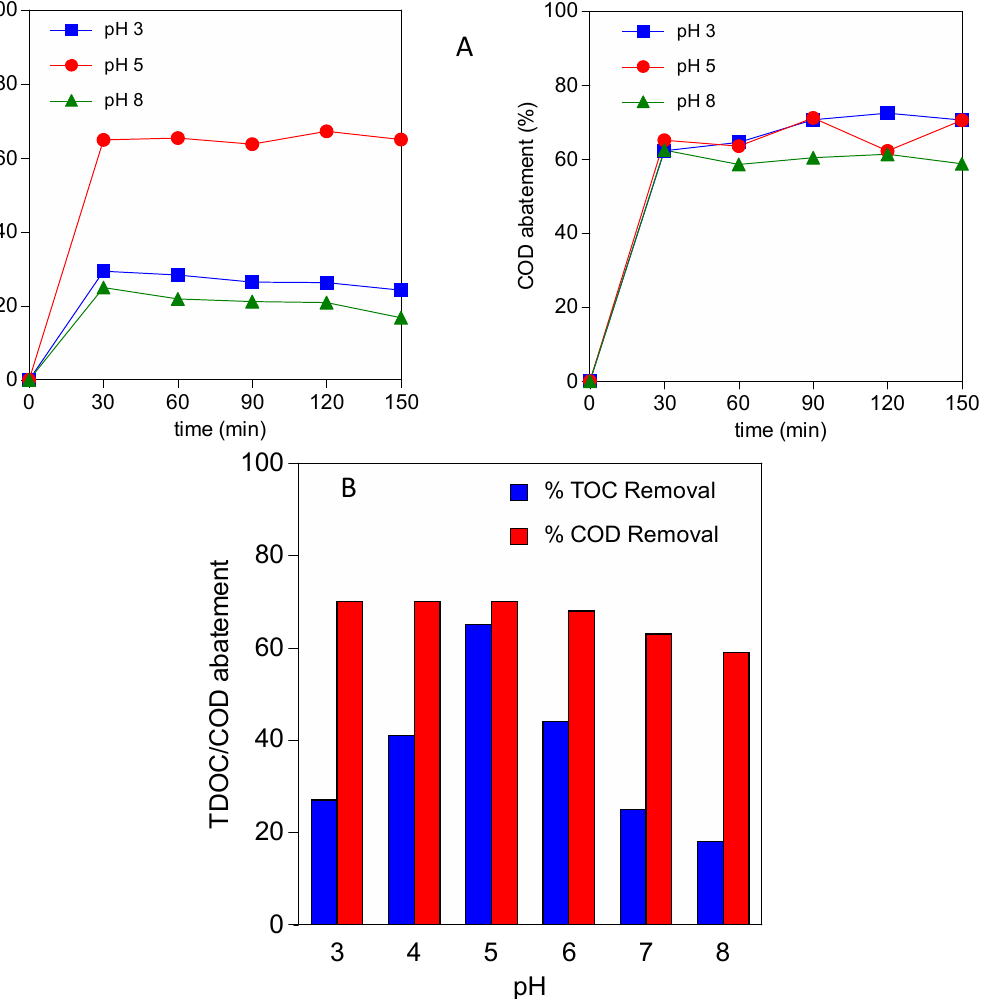
Figure 1. ( A ) Effect of pH on TDOC and COD removal efficiencies; ( B ) TDOC and COD removal efficiencies from pH 3 to 8 (reaction condition: 70 °C, 200 mg/L of catalyst, H 2 O 2 30 mL/L and reaction time 150 min).